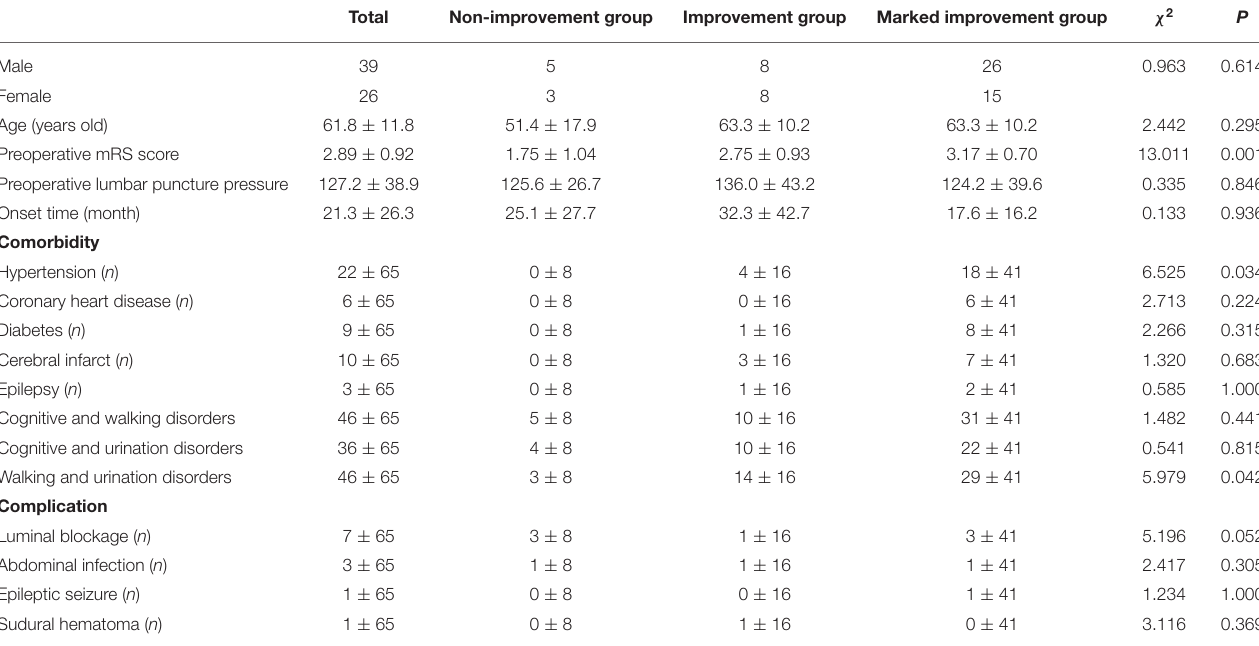
TABLE 3 | Analysis of related factors affecting the effect of the ventriculoperitoneal (VP)